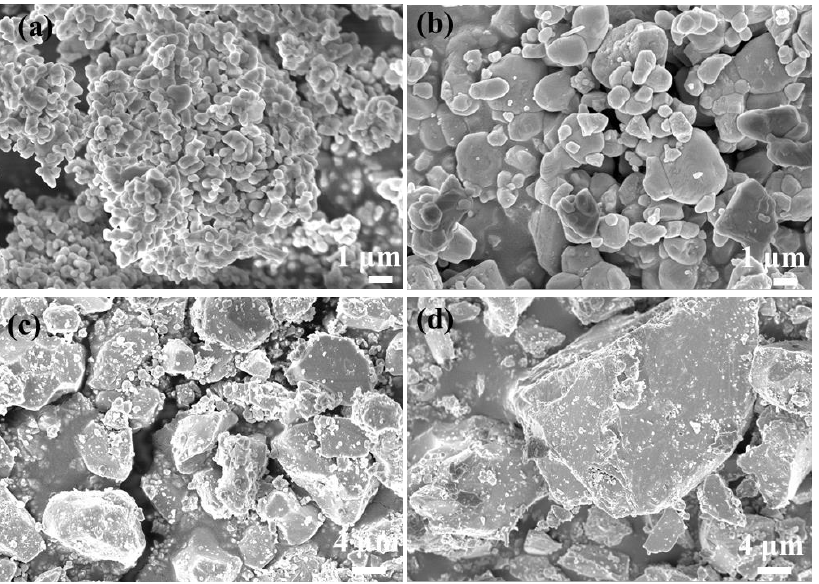
Figure 4. SEM images of ( a ) BaF( p −BDC) 0.5 −M500, ( b ) BaF( p −BDC) 0.5 -M600, ( c ) BaF( p −BDC) 0.5 −M700, ( d ) BaF( p −BDC) 0.5 −M800. The scale bar of ( a ), ( b ), ( c ) and ( d ) are 1 μm, 1 μm, 4 μm and 4 μm, respec- tively.